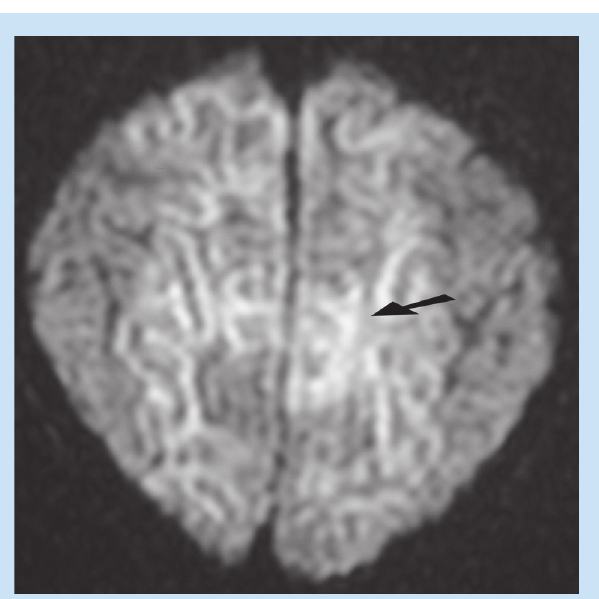
markings represent severe oedema as result of hypoxia.